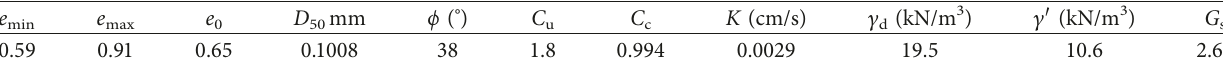
Figure 6: Particle size distribution curve. Table 1: Physical parameters for sand used in the test.